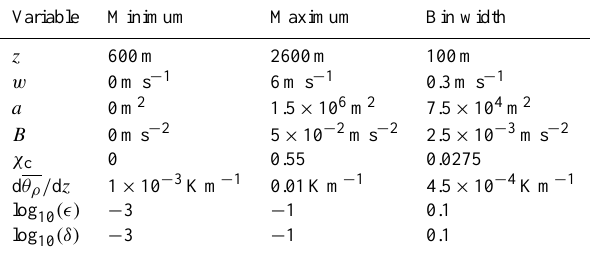
Table 1. Data limits and bin widths used to calculate